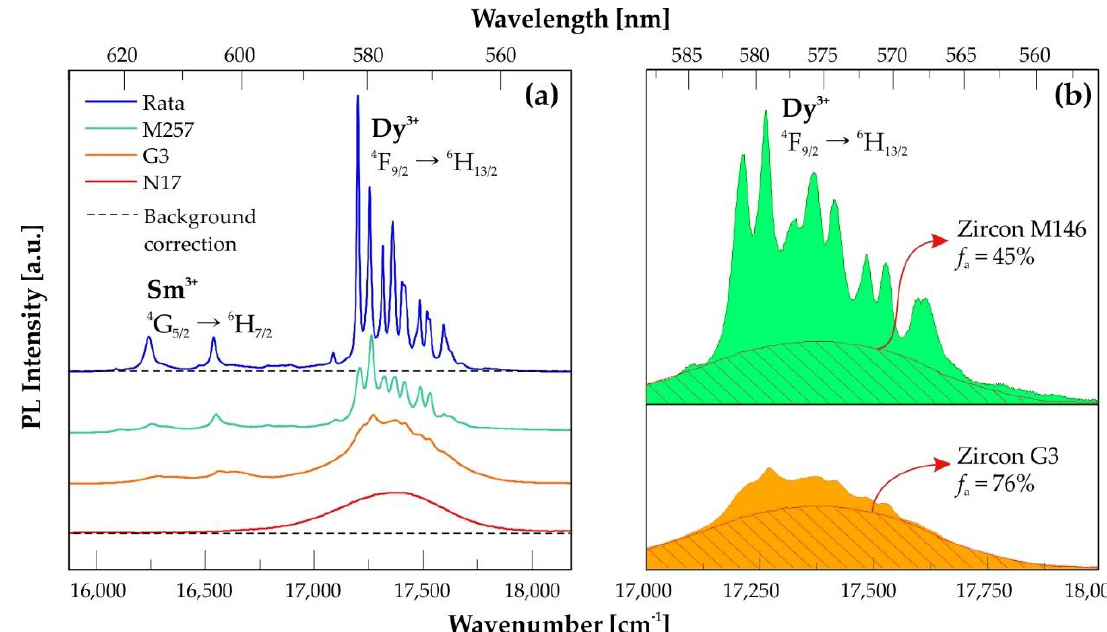
Figure 1. ( a ) Typical laser-induced photoluminescence spectra (λ exc = 473 nm) of zircon from Ratanakiri, Cambodia (Rata) and Ratnapura, Sri Lanka (M257, G3, N17). Emissions of Sm 3+ and Dy 3+ were identified in the yellow spectral range between 550 and 620 nm. Crystal-field split sub-level bands broaden and decrease in intensity with progressive accumulation of radiation damage from damage-free (Rata) to completely amorphised sample N17. ( b ) The Dy 3+ emissions of partly radiation-damaged zircon samples M146 and G3 are characterised by broadened crystal-field split sub-level bands which superimpose a broad background component that resembles the shape of sample’s N17 emission of Dy 3+ .